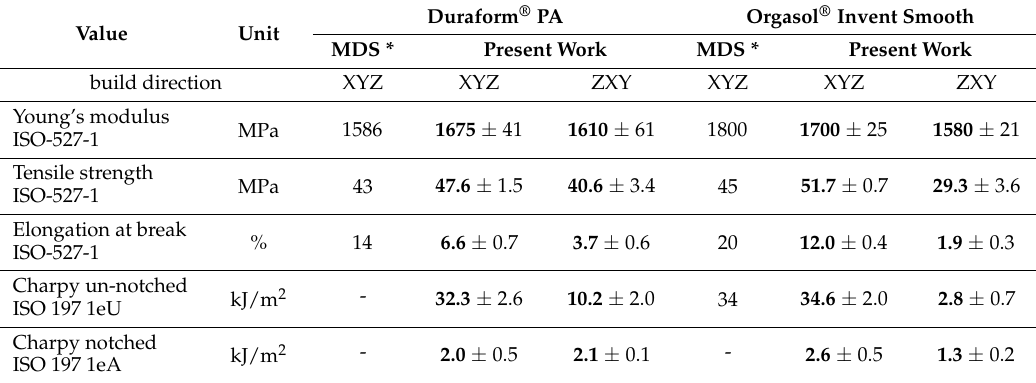
* MDS = material data sheets of powder